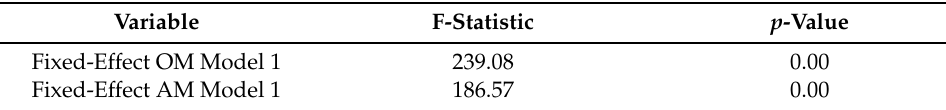
Table A5. Wooldridge test for autocorrelation in panel data.